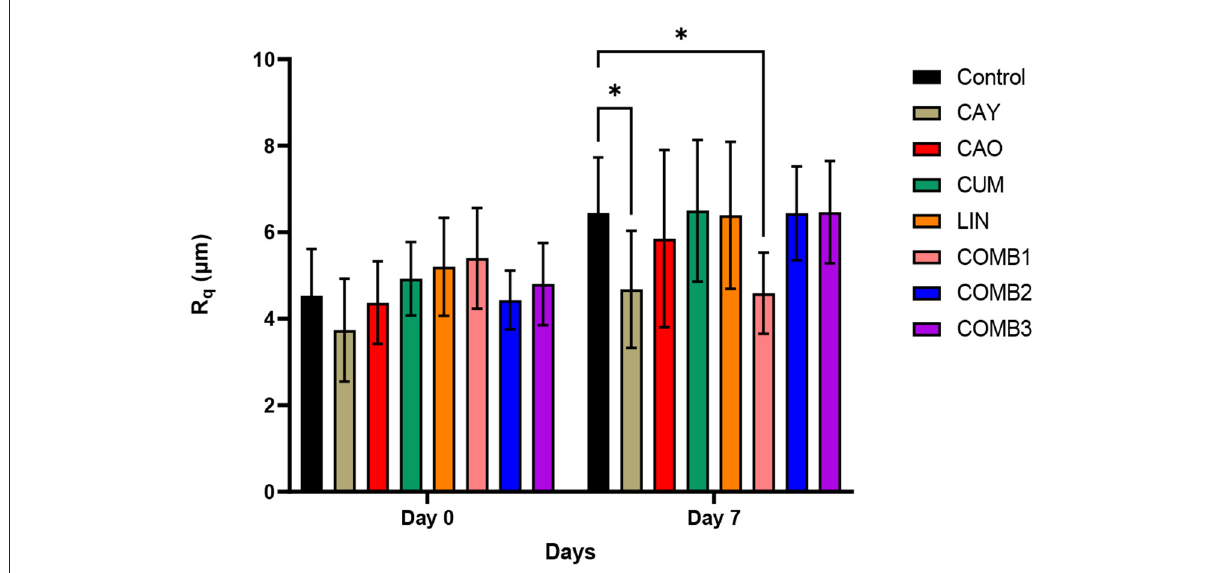
FIGURE2 Root mean square surface roughness (R q ) measures from amplitude trace images captured from chicken eggshell by means of AFM. The differences between the means were compared at a significance level of 5%. Error bars represent SEM. The * symbol indicates values of p < 0.05 which are statistically significant